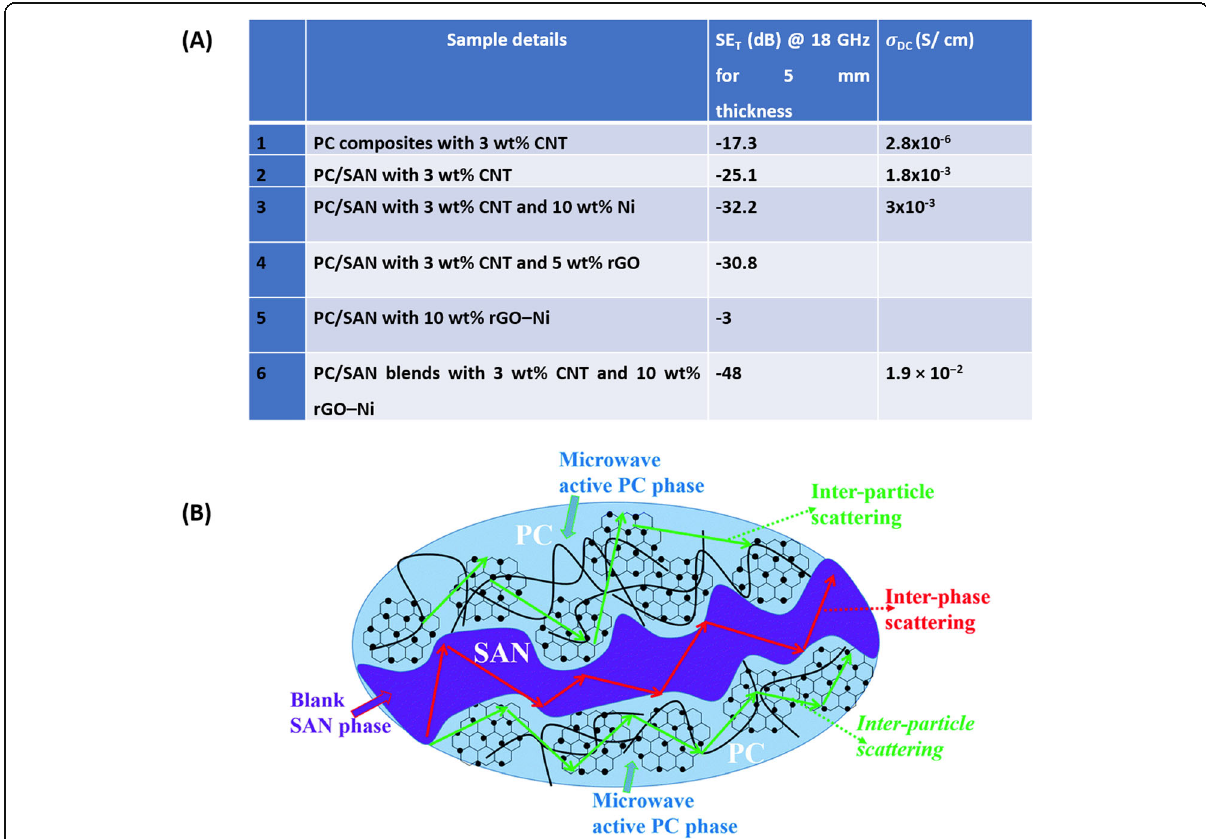
Fig. 16 (A) SE T and σ DC (obtained from dc plateau of bulk conductivity measurement) of different samples; ( B ) Cartoon illustrating the shielding mechanism. Adapted with permission from Bose et al. [92], copyright 2016 Royal Society of